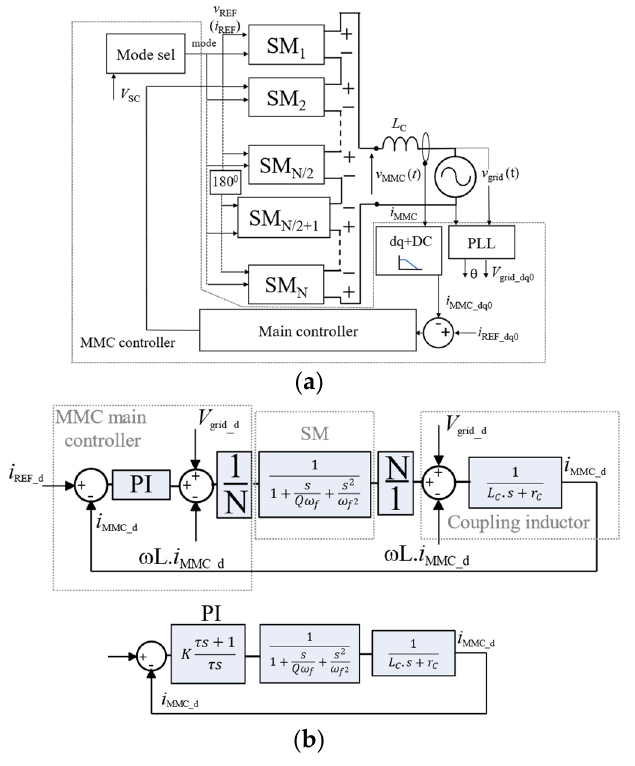
Figure 10. MMC controller ( a ) general scheme, ( b ) detail of d-component loop.